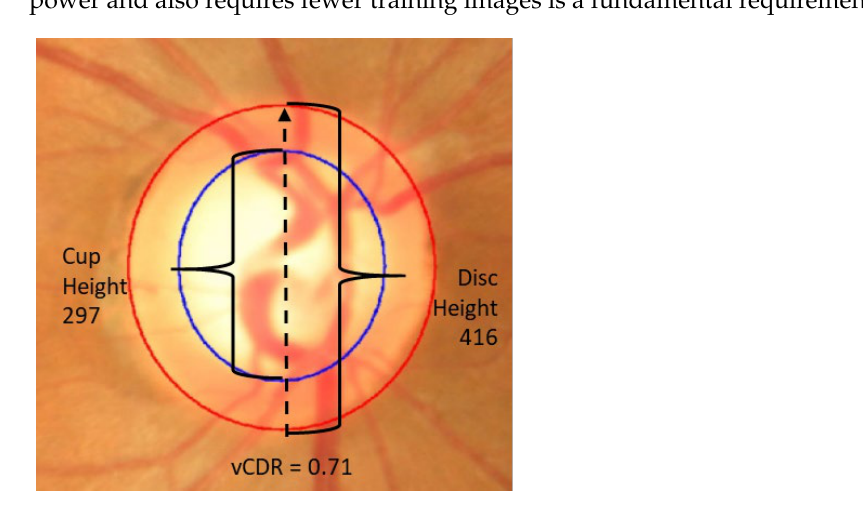
Figure 1. Colour fundus photograph of optic disc with two features: disc (red) and cup (blue).